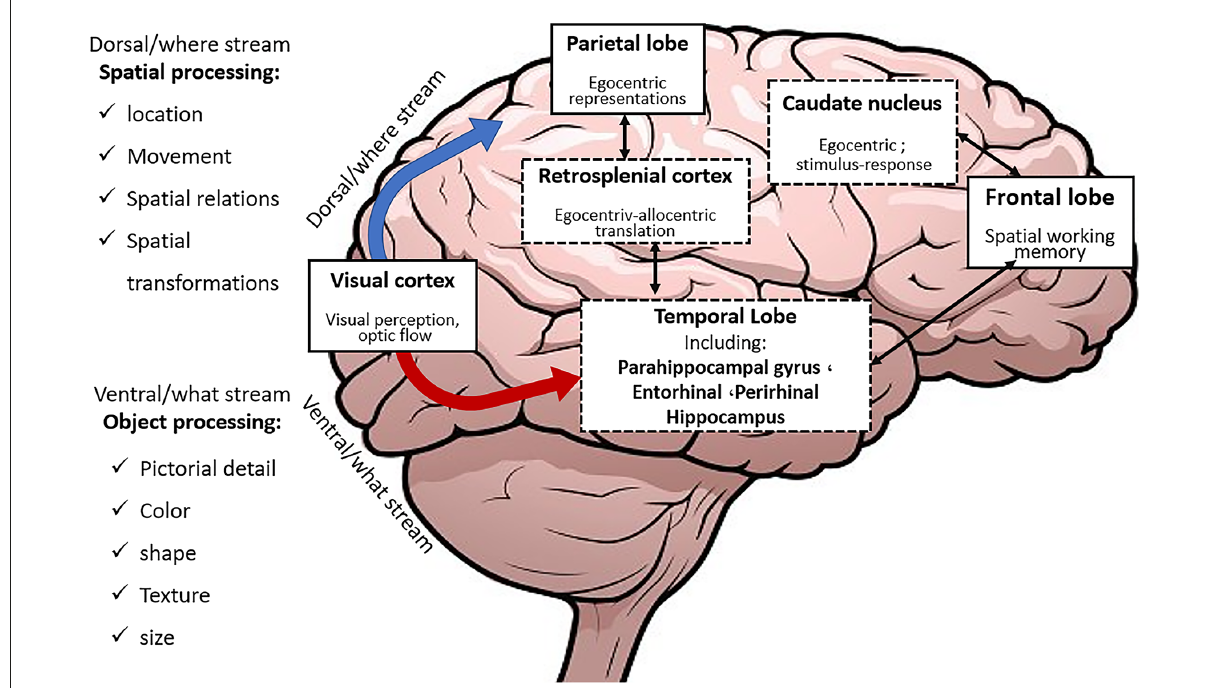
FIGURE2 The What and Where streams within the brain.